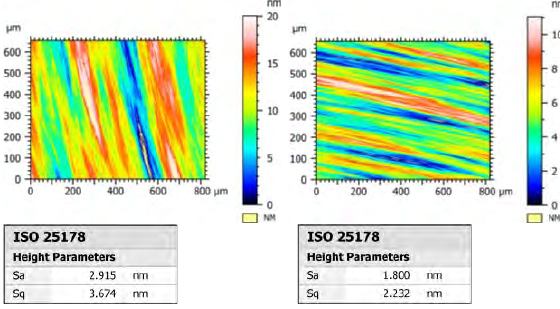
Fig . 15 . Comparsion of the fully polished zones of the sample grinded with D151 (left) and D30 (right) tool measured with whitelight interferometer. Lateral resolution of both mesurement is 1.22 – 780 mm -1